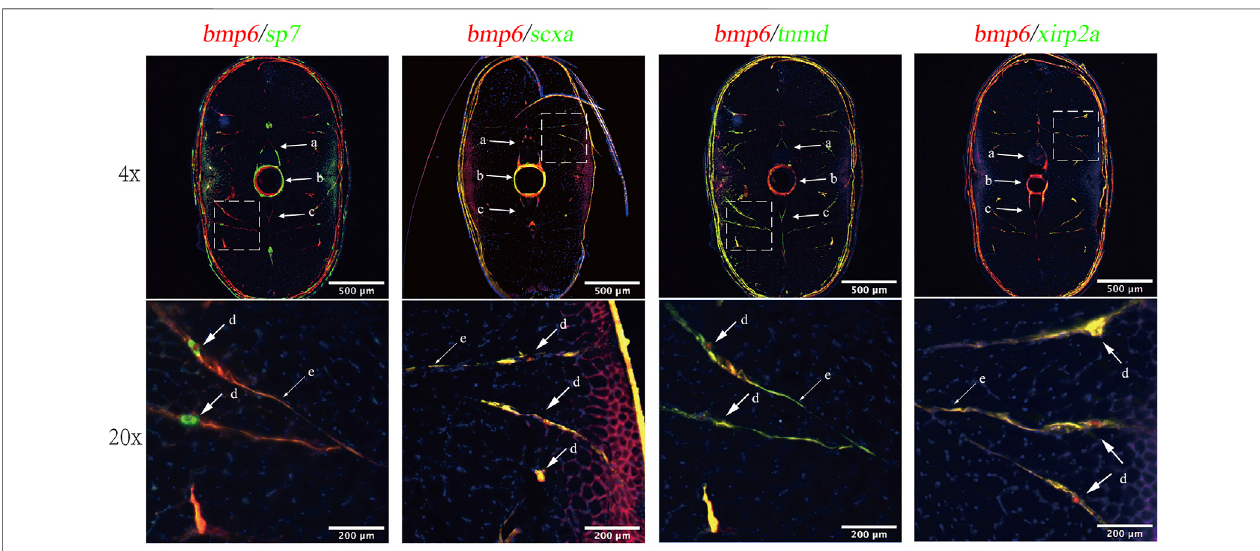
FIGURE 3 | RNA-FISH of bmp6 and co-expression analysis of sp7, tnmd, scxa, and xirp2a in the transverse section of zebra fi sh caudal musculoskeleton tissues. The mRNA of bmp6 was detected with Alexa Fluor 647 fl uorescent probes, while mRNA of scxa , tnmd , and xirp2a was detected with Alexa Fluro 532 probes, and the nucleus was stained with DAPI dye. Intermuscular bones were marked with dotted line boxes at the top of the panel and were enlarged 20 times at the bottom of the panel. Arrows indicated IBs. a: neural arches; b: vertebrae; c: hemal arches; d: IBs; and e: myoseptum.